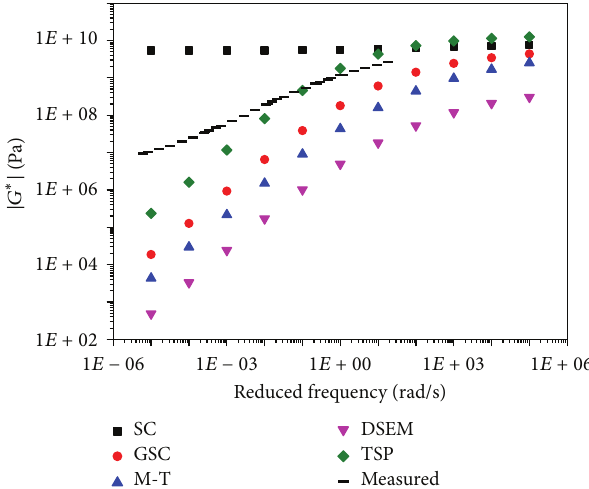
Figure 5: Predicted and measured dynamic shear modulus of mortar.